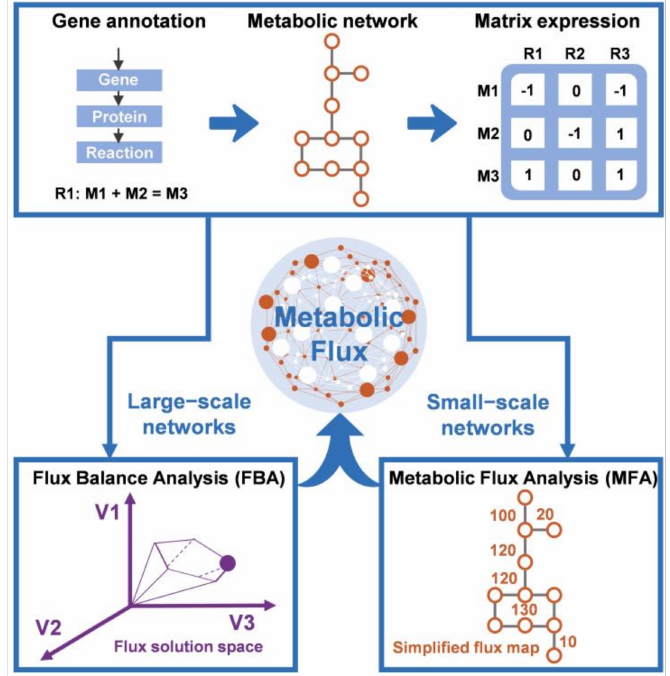
Figure 1. Schematic of constraint-based modeling (CBM)